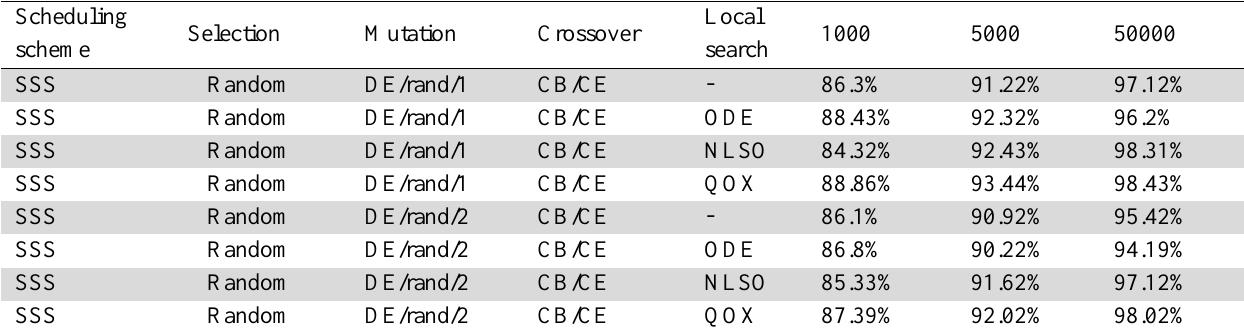
Effect of schedule generation scheme, mutation operators, and selection method on average deviation Scheduling scheme